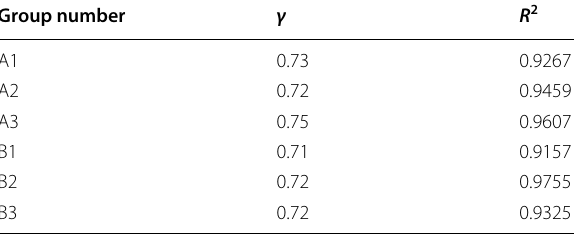
Table 6 Fitting values of γ for